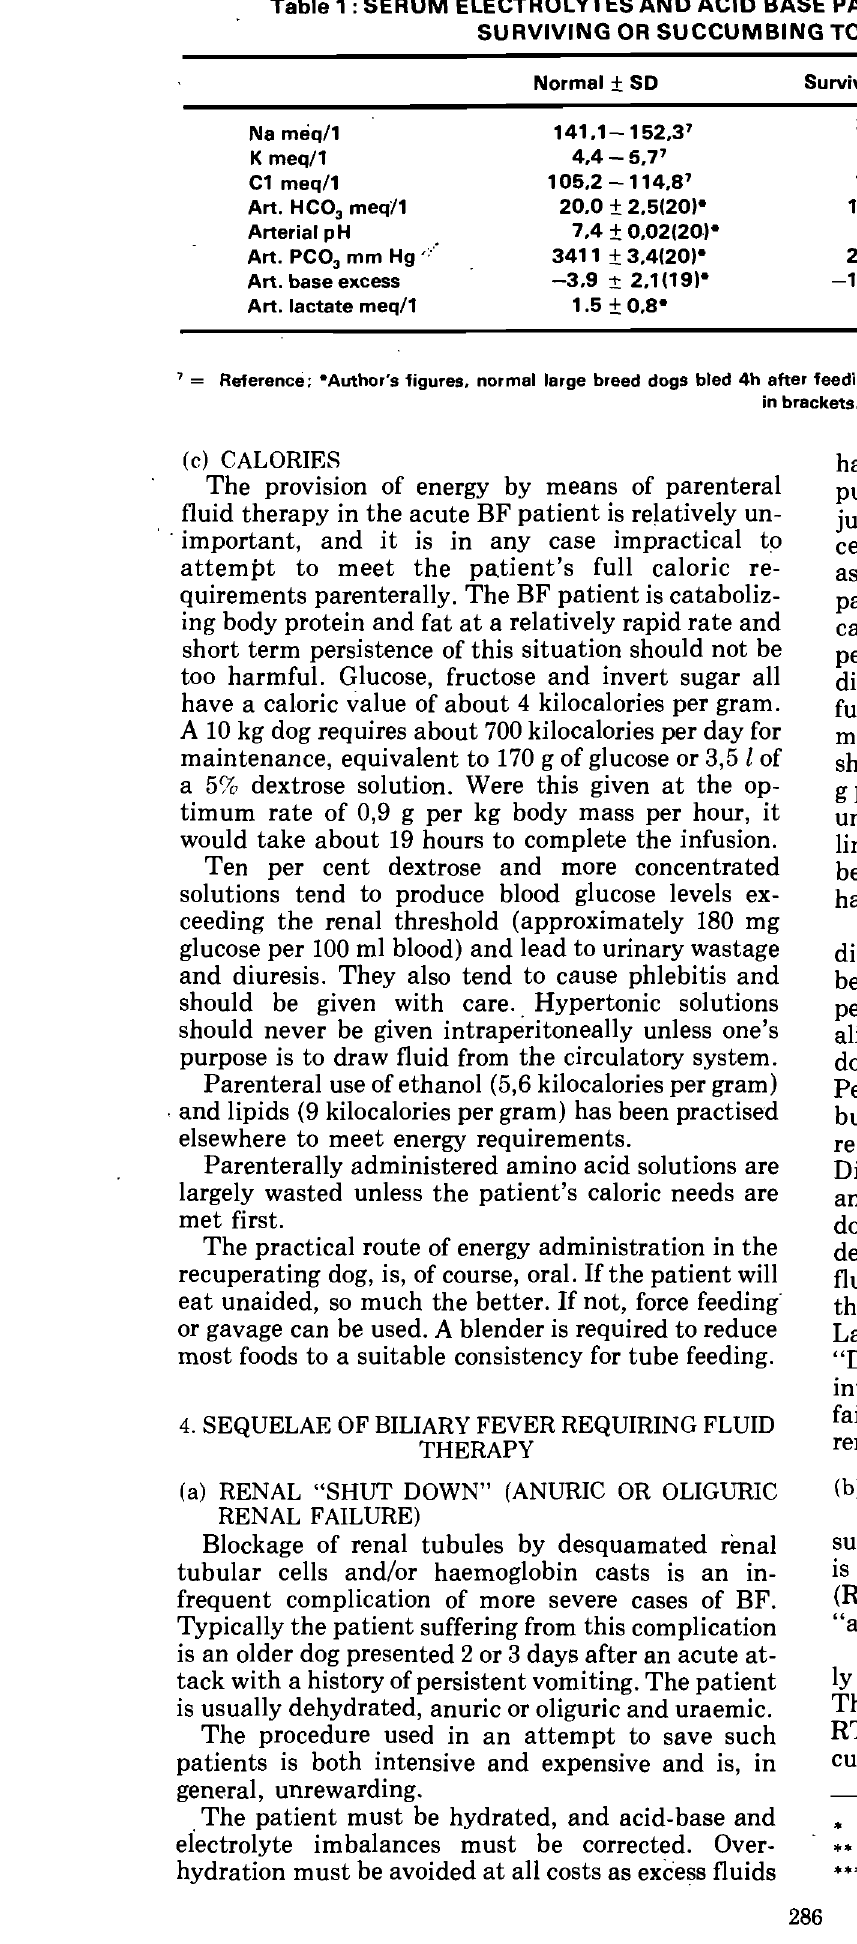
r Table 1: SERUM ELECTROLYTES AND ACID BASE PARAMETERS IN NORMAL DOGS AN.D